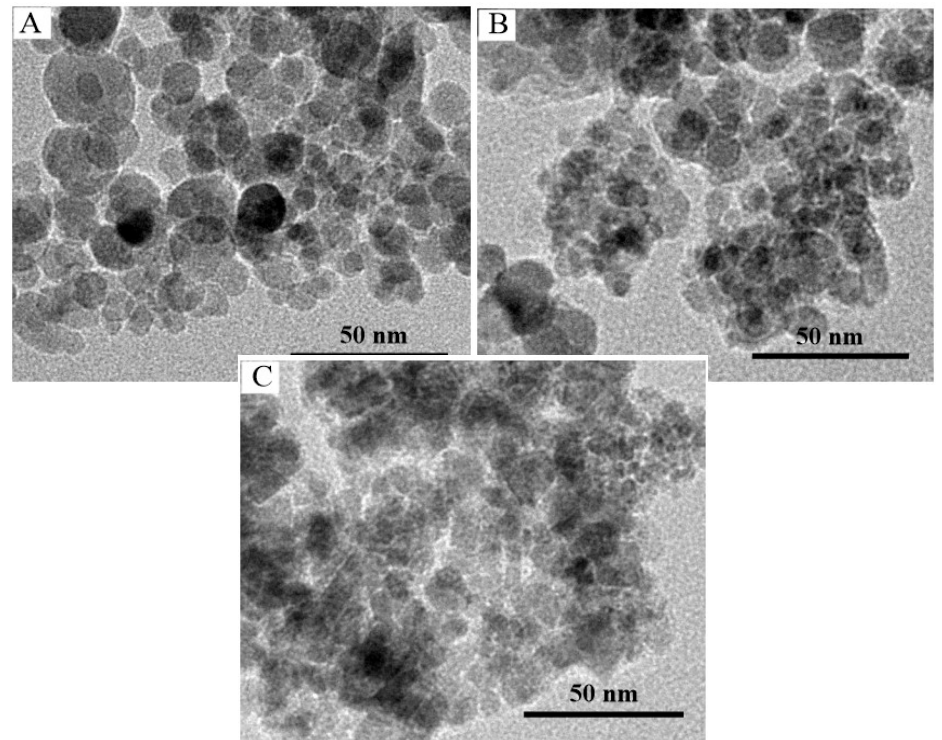
Figure 1. TEM images of Fe 3 O 4 ( A ), Fe 3 O 4 nanoparticles coated with polydopamine possessing abundant amino groups (Fe 3 O 4 @PDA) ( B ), and the aforementioned used as a supporting matrix for immobilizing Thermomyces lanuginosus lipase (Fe 3 O 4 @PDA@TLL) ( C ).